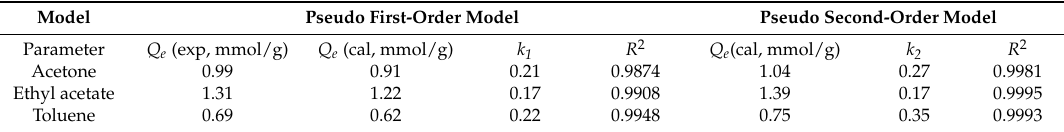
Table 5. Adsorption kinetics parameters of three probe VOCs. Q e = adsorption capacity at equilibrium. k 1 = pseudo first-order rate constant of adsorption. k 2 = pseudo second-order rate constant of adsorption. R 2 = correlation